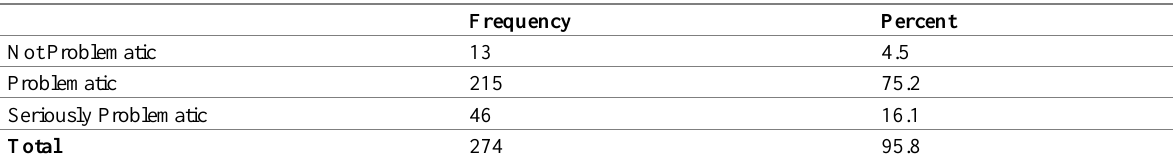
Table 3 : Gambling severity